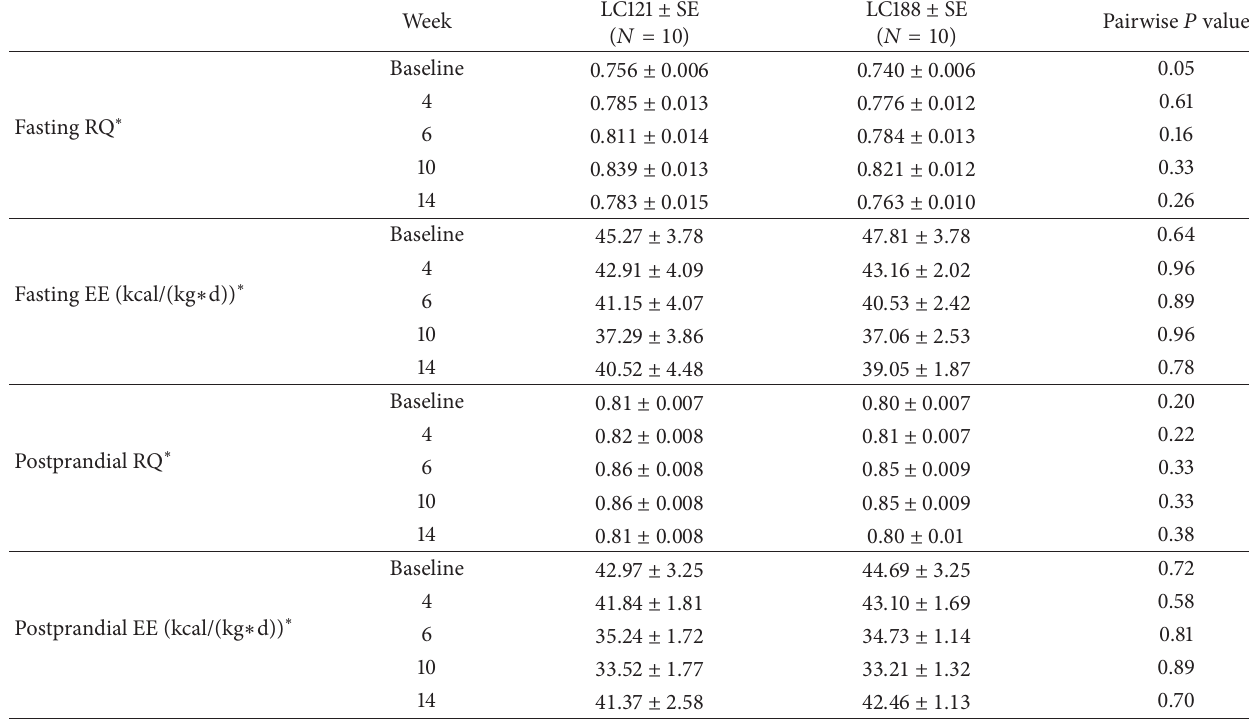
Table 3: Fasting and fed adjusted AUC for RQ and EE in adult cats fed LC121 or LC188 supplemented diets above their maintenance energy requirement at baseline and during the 16-week LC